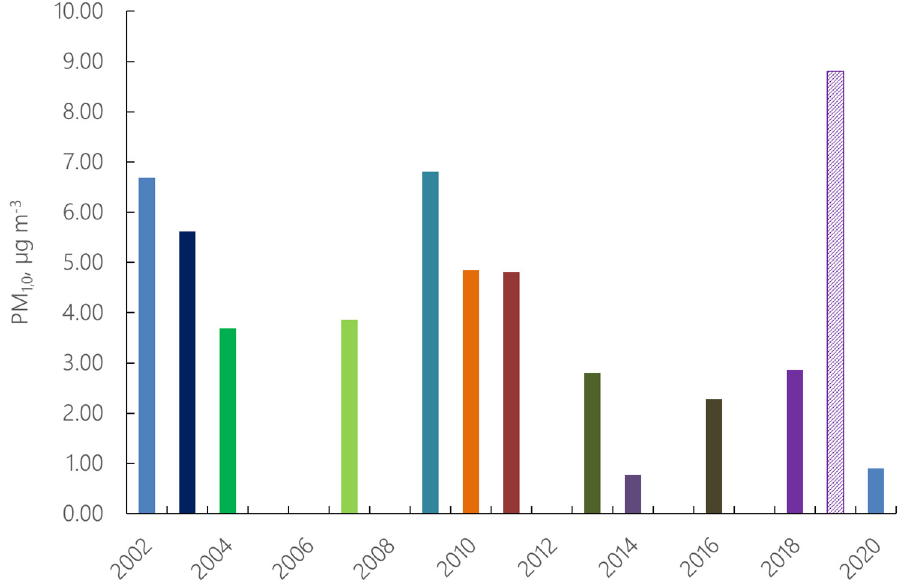
Figure 8. Annual changes in PM 1.0 (according to LAS data) for years of 2002–2020 at a high altitude. A dust storm was recorded on 1 August 2018: the average value of the mass concentration in 2018 has shown with (hatching) and without (solid) taking into account 1 August 2018.